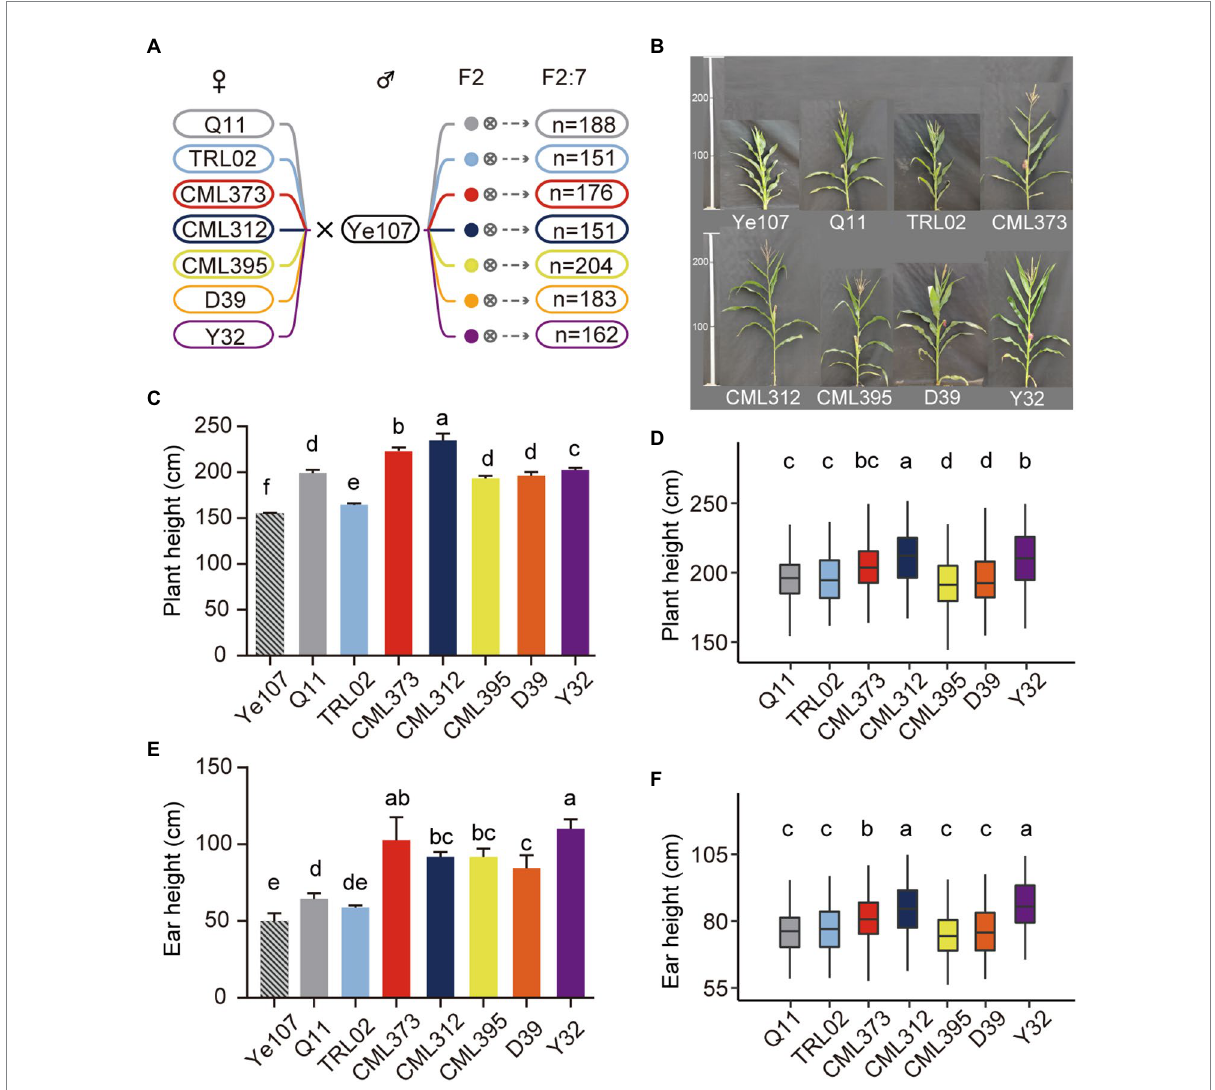
FIGURE 2 The population construction and morphological comparison of the plant height. (A) The number of families for each of the RIL population. (B) Phenotypes of each parental line. (C) Plant height of each parental line. (D) Plant height of each recombinant inbred line population. (E) Ear height of each parental line. (F) Ear height of each recombinant inbred line